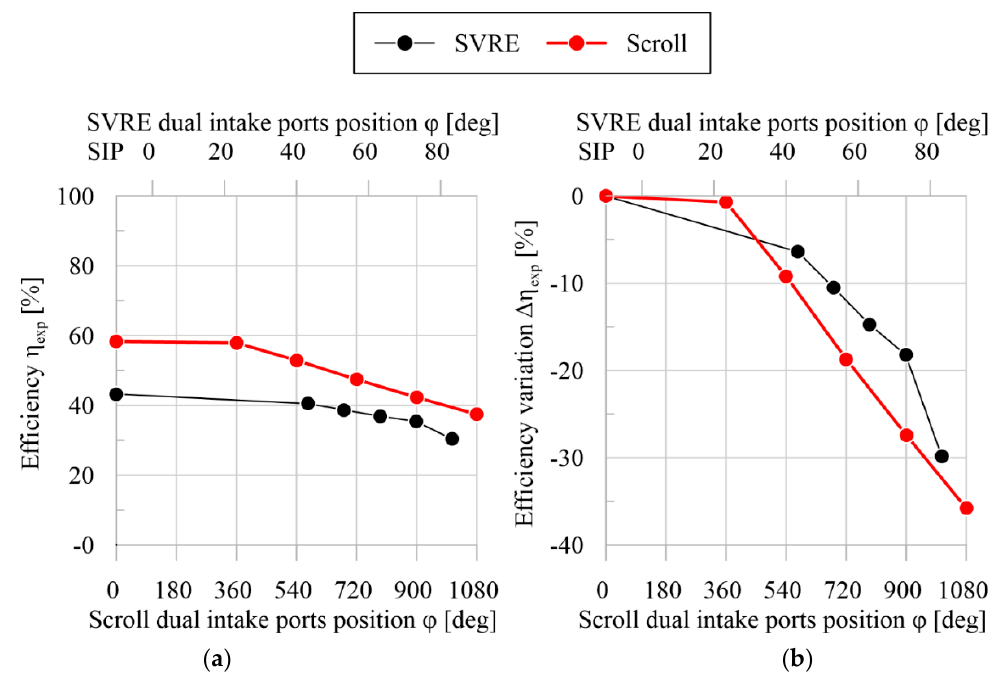
Figure 15. Efficiency η exp ( a ) and efficiency variation Δ η exp ( b ) induced by DIP in the SVRE and scroll expanders.